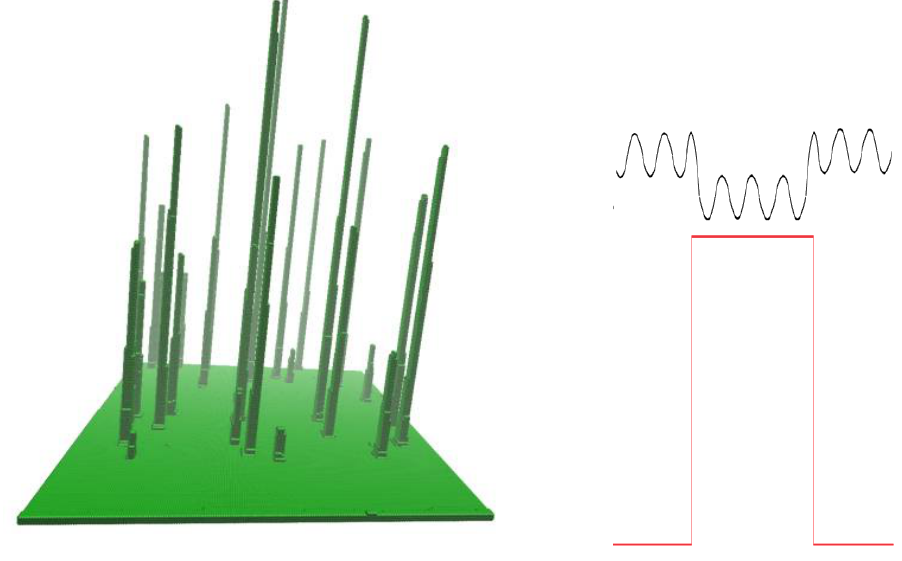
Figure 4. Nanowires, c 0 = 0.02, P iES = 0, P dES_asm = 0.1, p w = 1, n DS = 10, l 0 = 100. System size 200 × 200. Inset: potential that realizes given pattern.